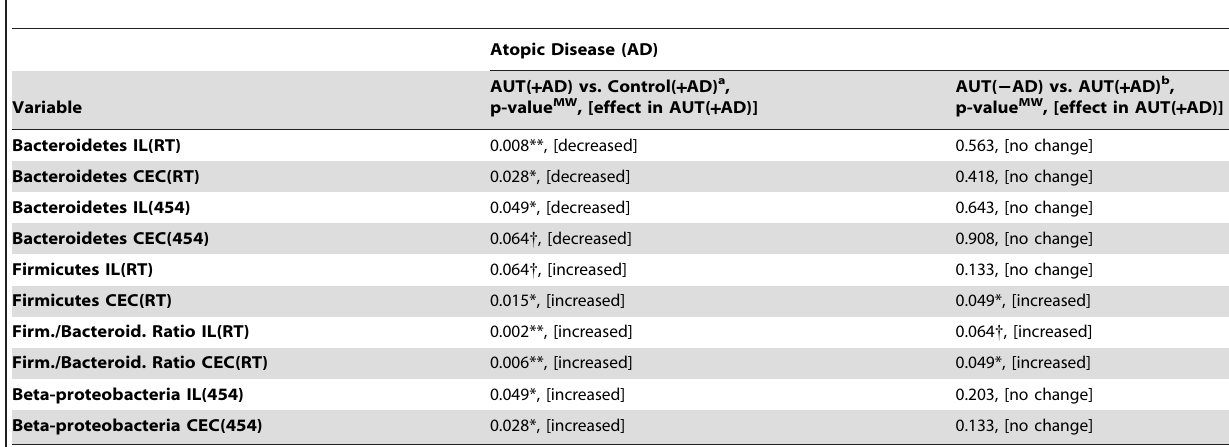
Table 8. Association of atopic disease (AD) status with host gene expression and bacterial phylotypes in AUT-GI children.